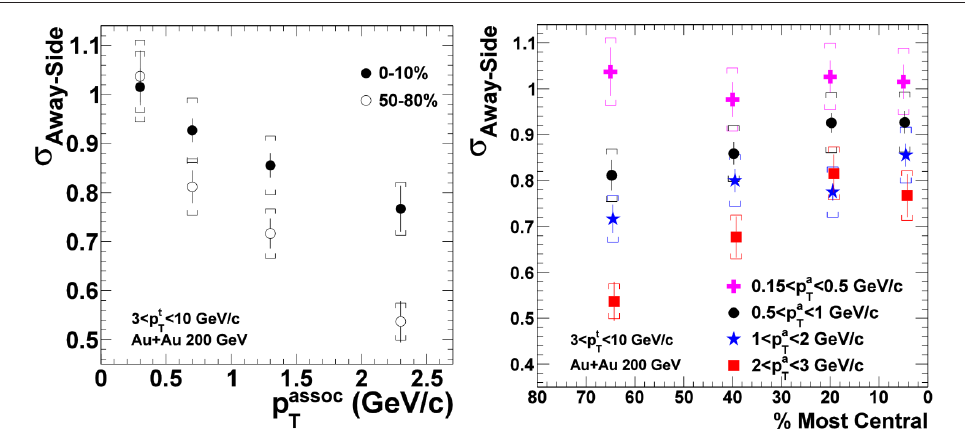
Figure 7. Left: Shape parameters σ δφ from away-side jet peak as a function of p T , assoc in most central and most peripheral Au-Au collisions at √ s NN = 200 GeV. Right: Shape parameters σ δφ from away- side jet peak as a function of centraility in di ff erent p T , assoc